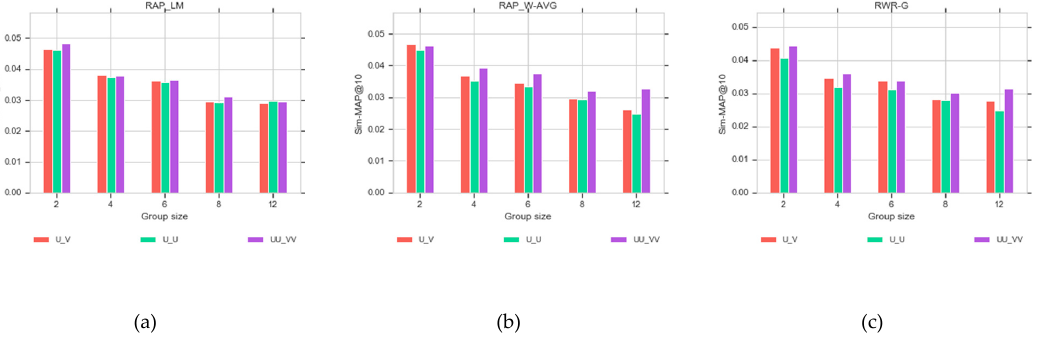
Figure 11. Sim-MAP values of CLGRW at top-10 recommendations (vertical axis) in different group recommendation strategies, including: ( a ) RAP_LM, ( b ) RAP_W-AVG, and ( c ) RWR-G at different group sizes (horizontal axis) and three graph models of U-V, U-U, and UU-VV graphs.